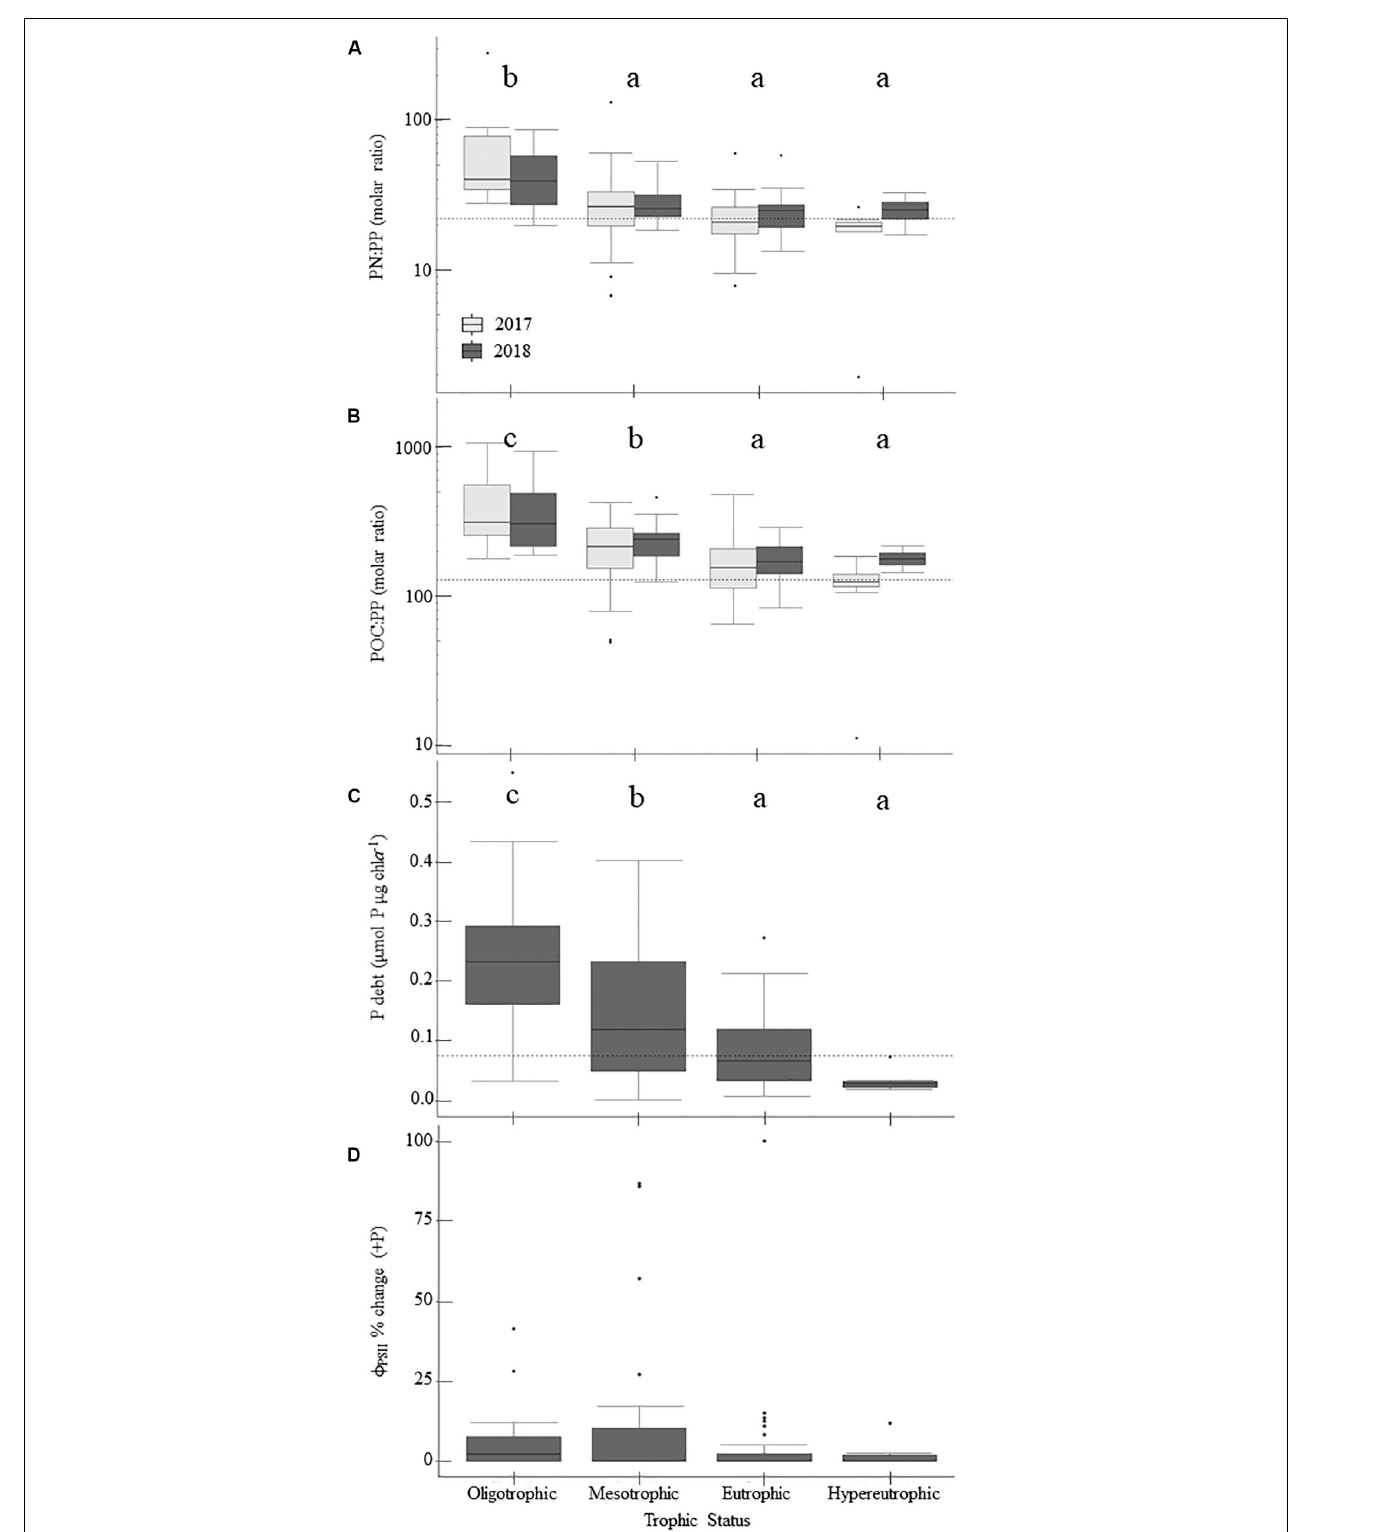
FIGURE 4 | Patterns in phosphorus-deficiency across the trophic gradient and 2-year sample period, if applicable, for parameters sampled in 2017 and 2018. Panels show particulate nitrogen to particulate phosphorus (PN:PP) ratios (A) , particulate organic carbon to particulate phosphorus (POC:PP) ratios (B) , phosphorus